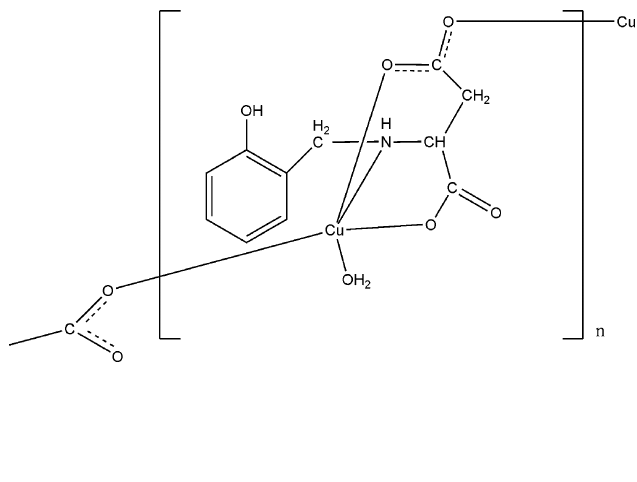
Hydrogen-bond geometry (A˚ , (cid:1)